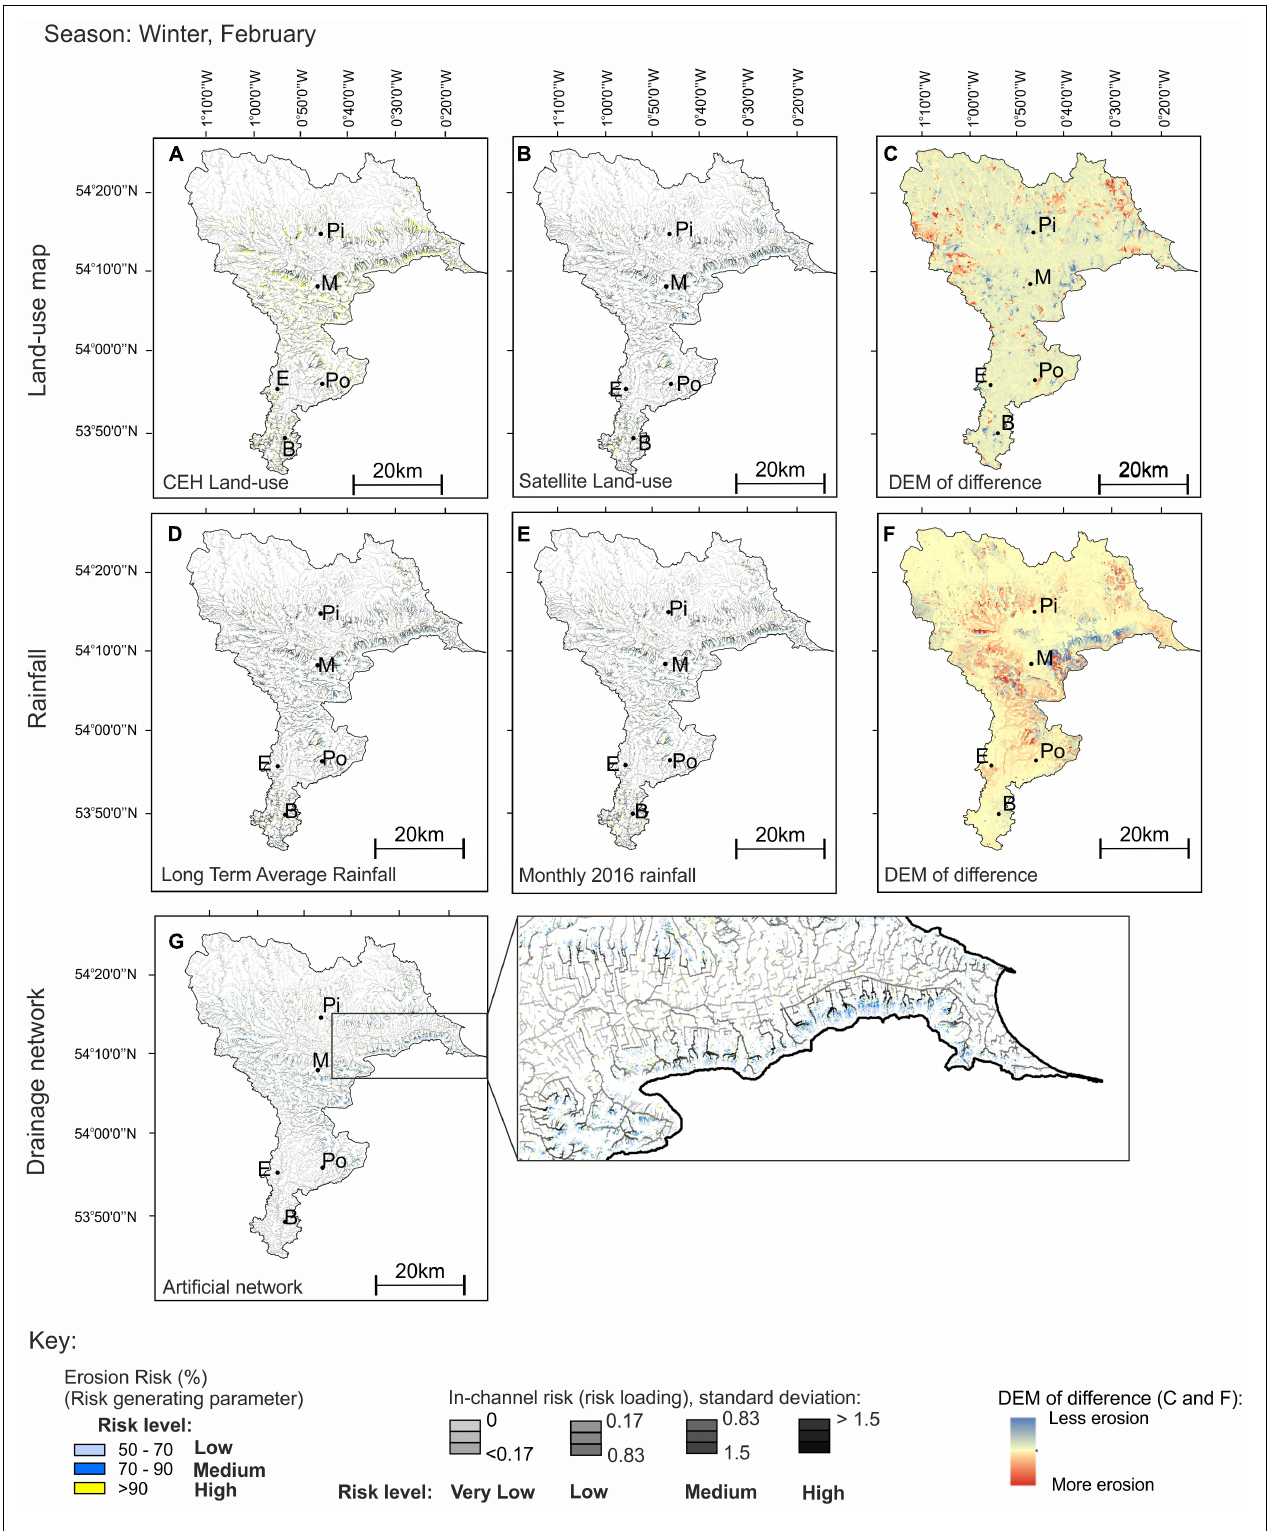
FIGURE 4 | Model scenario outputs for February, (A) CEH land use map; (B) satellite-derived land use map; (C) the DEM of difference between the two land use maps; (D) long-term rainfall average; (E) monthly rainfall totals; (F) the DEM of difference between the two rainfall scenarios; and (G) the artificial drainage network. Locations are shown on each map; Pi, Pickering; M, Malton; Po, Pocklington; E, Elvington; B, Bubwith.